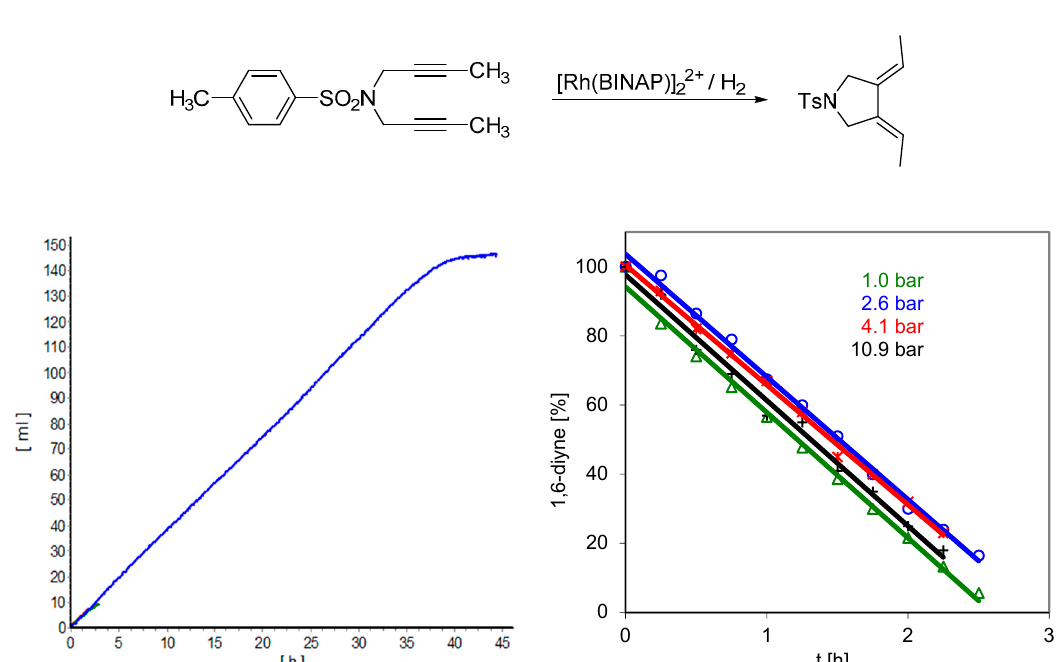
Figure 16. Rh / BINAP promoted cyclization of 1,6-diyne in DCM under a hydrogen atmosphere: hydrogen consumption (ml) as a function of time (h), left (0.01 mmol catalyst ([Rh(BINAP)] 22 + ), 0.33 or 3.30 mmol diyne, 25 ◦ C in 10 mL DCM at normal hydrogen pressure). 1,6-diyne conversion in % as a function of time, at di ff erent hydrogen pressures, right (0.01 mmol catalyst ([Rh(BINAP)] 22 + ), 0.33 mmol diyne, 25 ◦ C in 20 mL DCM at di ff erent hydrogen pressures).